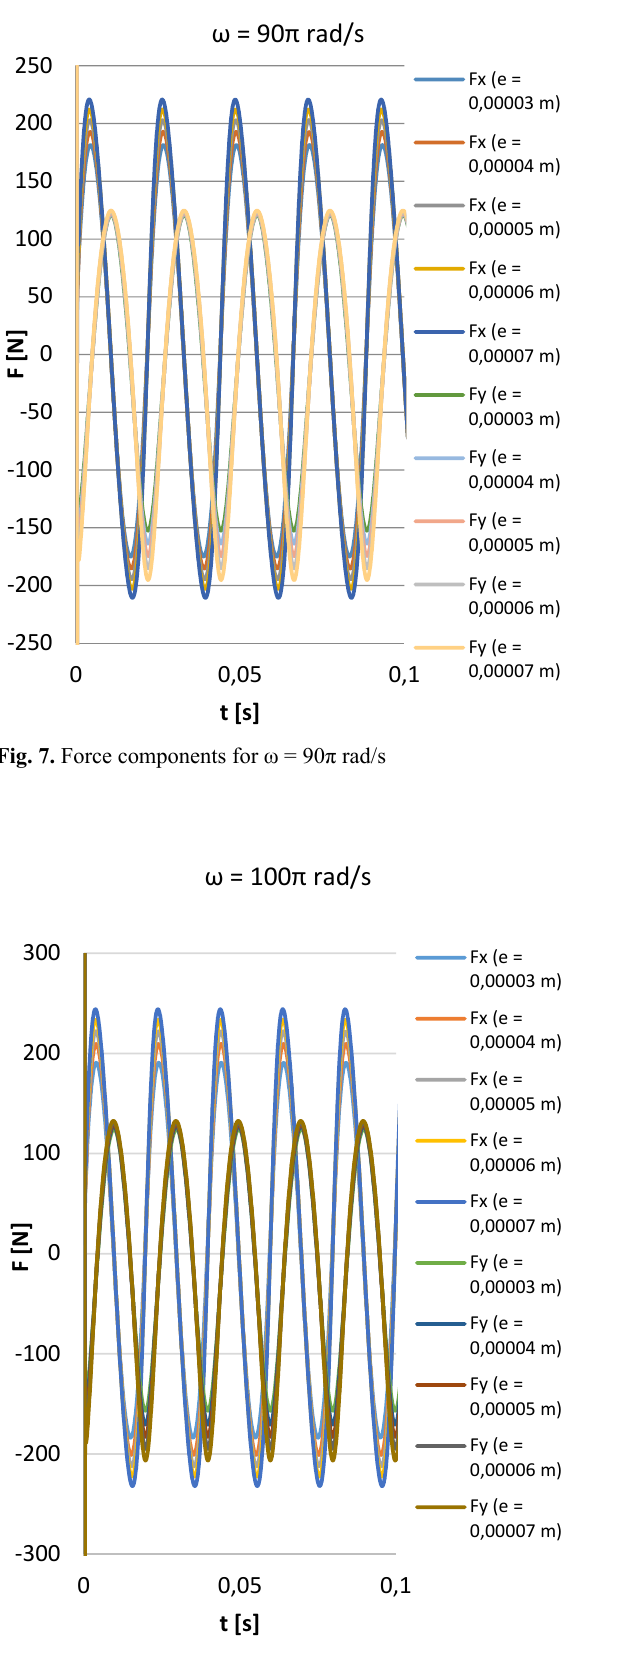
Fig. 8. Force components for ω = 100 π rad/s